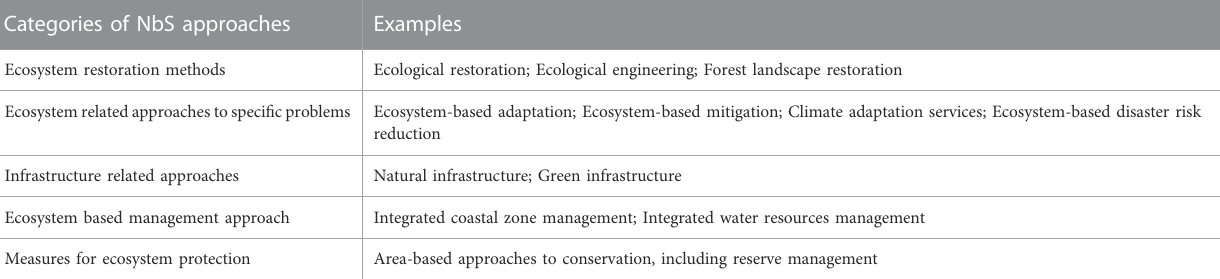
TABLE 2 Categories and examples of NbS approaches. Categories of NbS